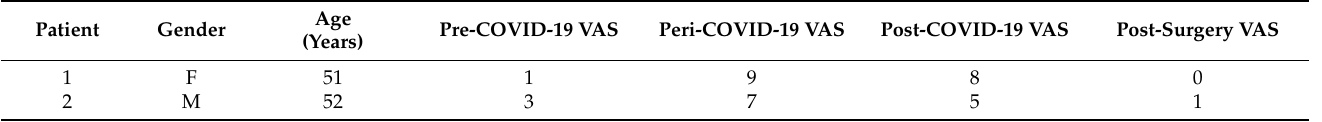
Table 1. VAS score in patients prior to, during, and after COVID-19 infection and after surgery. Patient